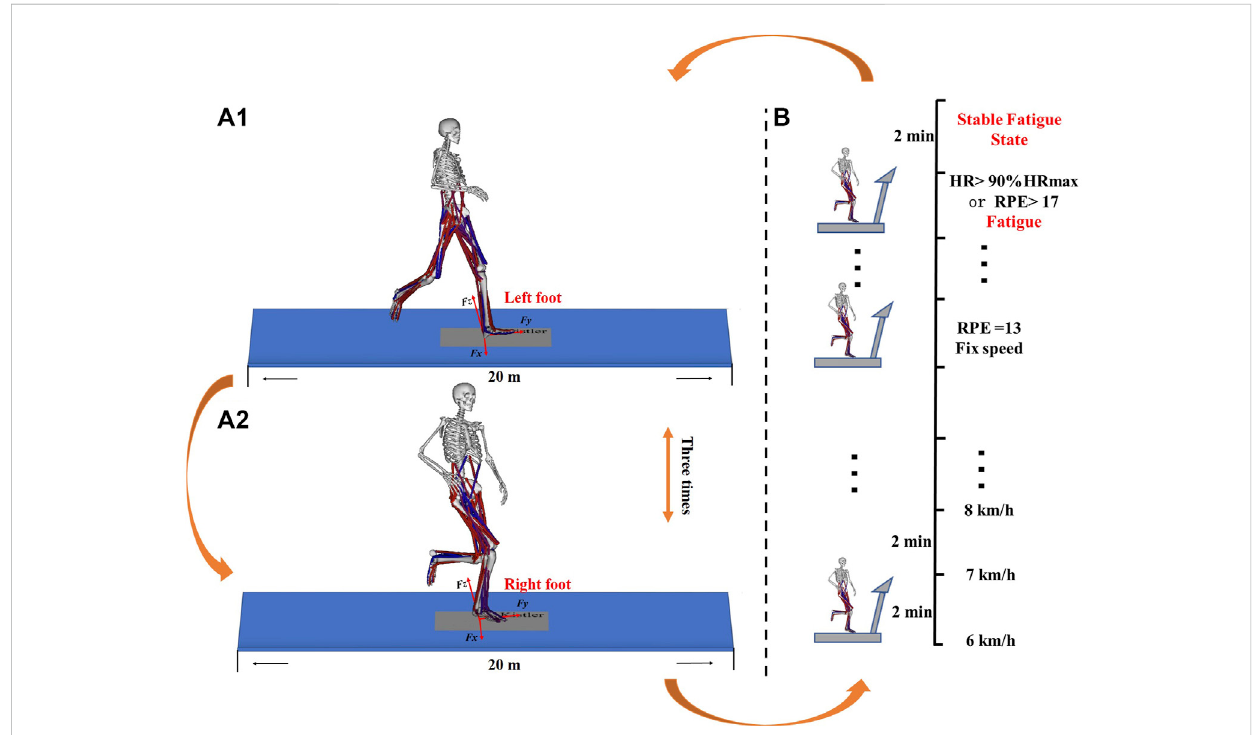
FIGURE 1 Bilateral data collection execution process. (A1) Right GRF data collection process. (A2) Left GRF data collection process. (B) Running-induced Fatigue Protocol Test implementation